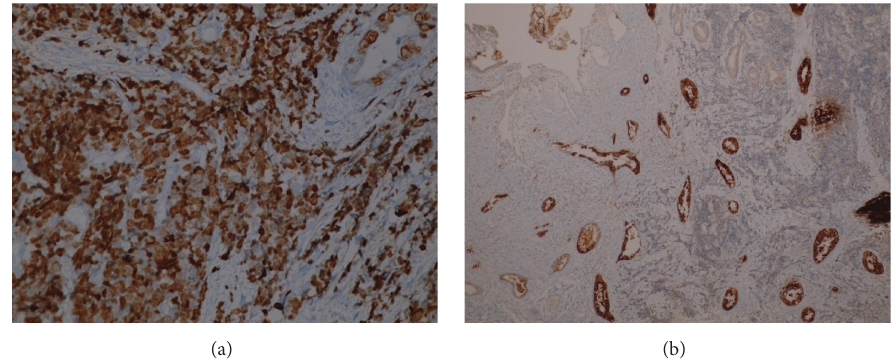
Figure 3: (a) IHC of MANEC with Ki67 400x: 90% in the NEC component and lesser in the adenocarcinoma component. (b) IHC of MANEC with CEA 100x highlights the adenocarcinoma